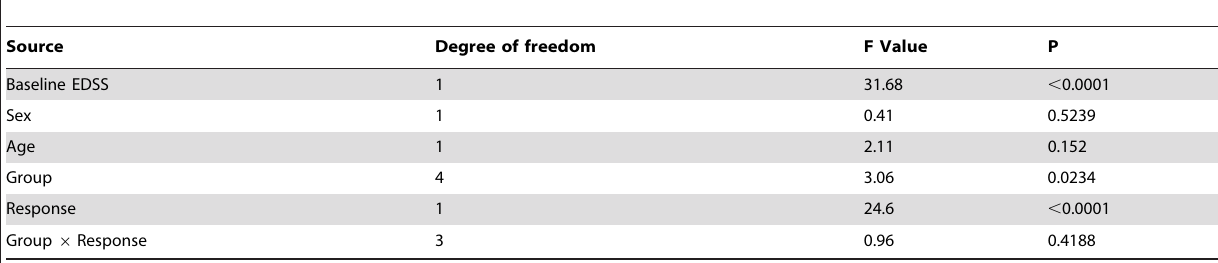
Table 3. Analysis of covariance in EDSSp post-interferon- b therapy.